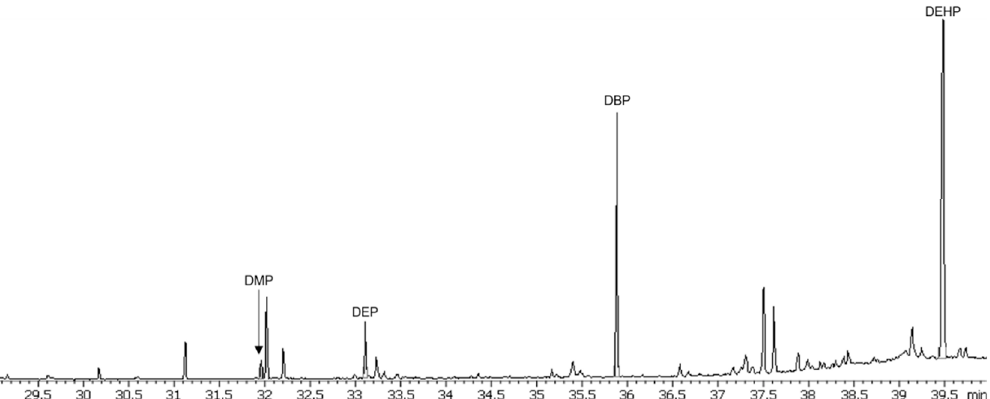
Figure 4. GC-MS chromatogram obtained from the analysis of a leachate sample spiked at 250 µg/L by on line RPLC-GC-MS using a fraction collector.